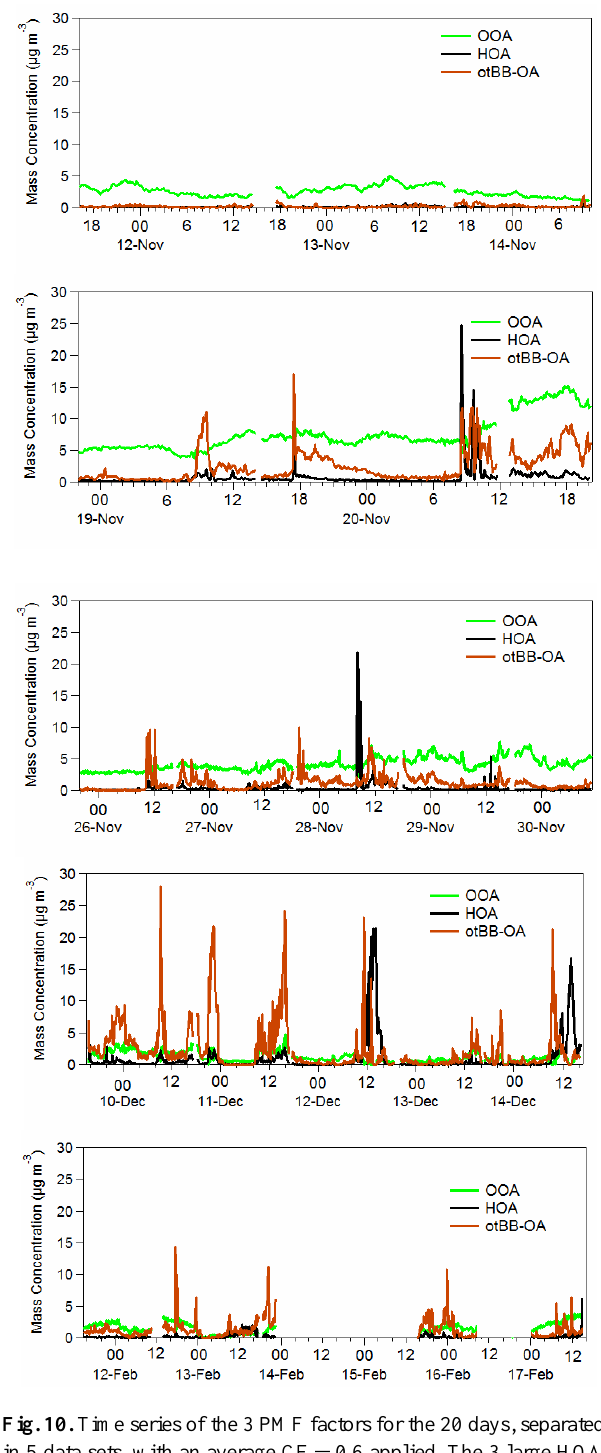
Fig. 10. Time series of the 3 PMF factors for the 20 days, separated in 5 data sets, with an average CE = 0.6 applied. The 3 large HOA spikes on 28 November and 12 and 14 December are probably due to the Institute diesel power generator, which was activated during a series of power outages.